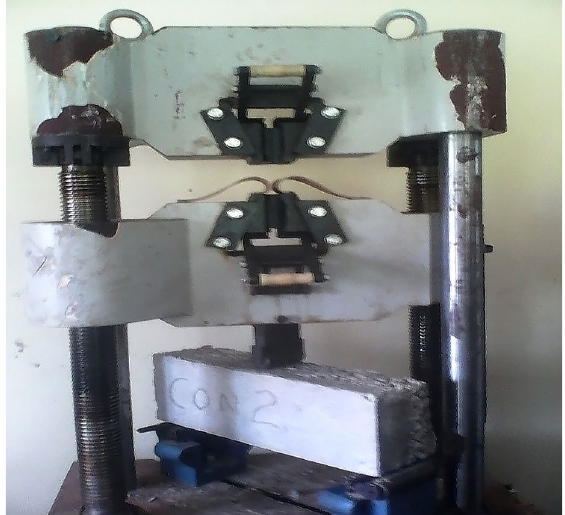
Fig. 2. Beam under load